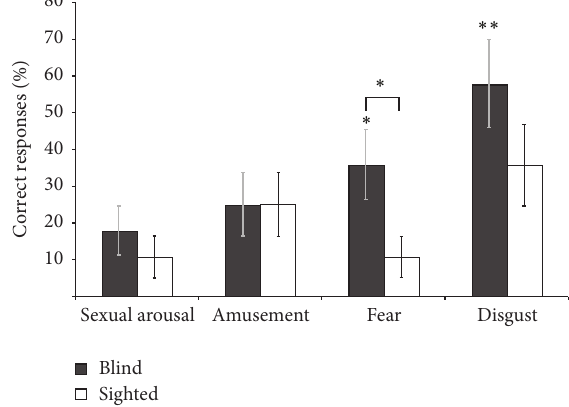
Figure 5: Results of the odour identification task of male sweat samples. Congenitally blind participants were significantly better than sighted controls at identifying fear from males and also had a strong tendency to be better at identifying disgust from males. None of the groups were above chance level (20%) for amusement or sexual arousal. Data presentmean ± SD. ∗ 𝑃 < 0.05 ; ∗∗ 𝑃 < 0.01